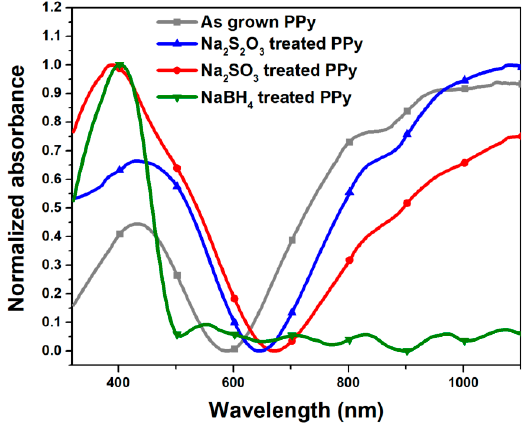
Figure 5. UV–Vis–NIR spectra of PPy grown by VPP on a glass substrate. Measurements were run during reduction treatments in Na 2 S 2 O 3, Na 2 SO 3 and NaBH 4 10 wt% solution in demineralized water. Table 1. Redox potential of Na 2 S 2 O 3 , Na 2 SO 3 and NaBH 4 vs. a standard hydrogen electrode (SHE). NaBH 4 Na 2 SO 3 NaS 2 O 3 Redox potential vs. SHE − 1.24 V − 0.93 V − 0.57